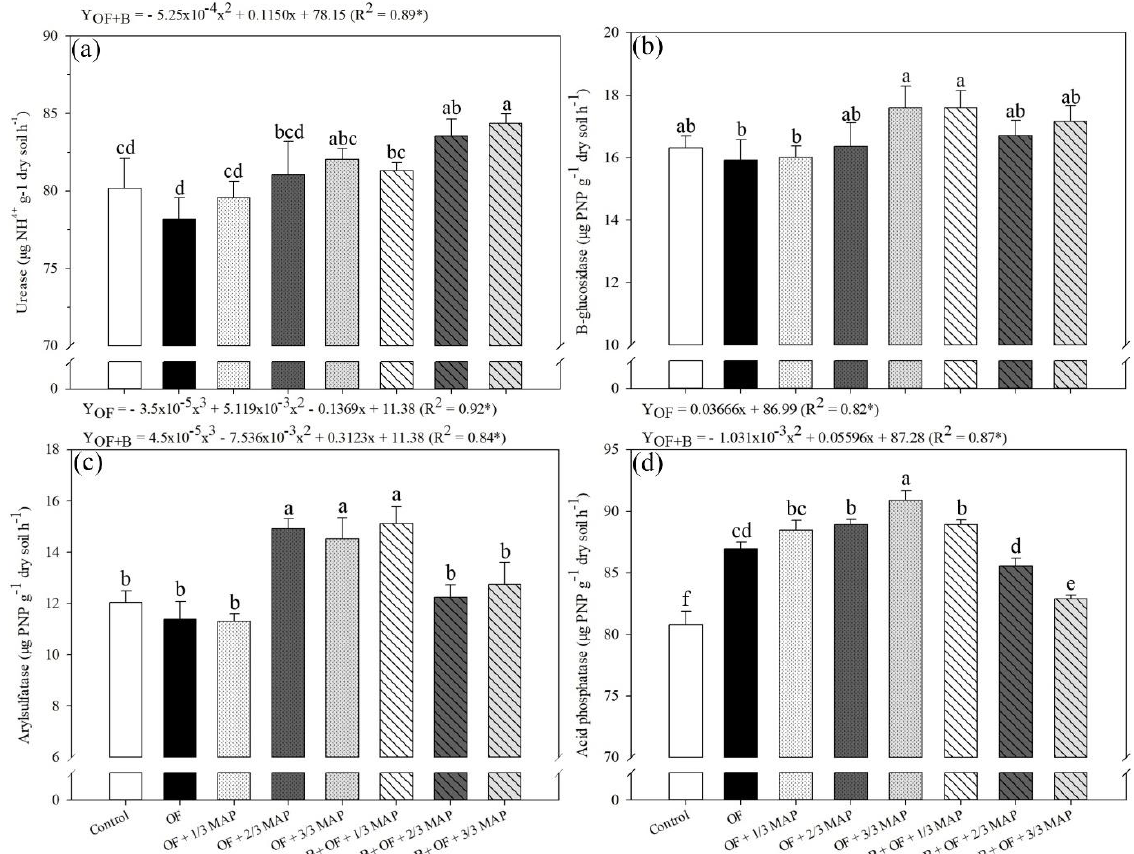
Figure 6. Urease ( a ), B-glycosidase ( b ), arylsulfatase ( c ), and acid phosphatase activity ( d ) of the sugarcane cultivation soil under the association of organomineral fertilizer (OF), B. velezensis (B), and doses of mono ammonium phosphate (MAP). Means followed by the same letter do not differ from each other by the Tukey test at 5% probability. The error bars express the standard deviation of the mean (n = 4). The regression equations and R 2 above the figures include the MAP doses associated with organomineral fertilizer (OF) and with organomineral fertilizer + B. velezensis (OF + B) at the 5% significance level